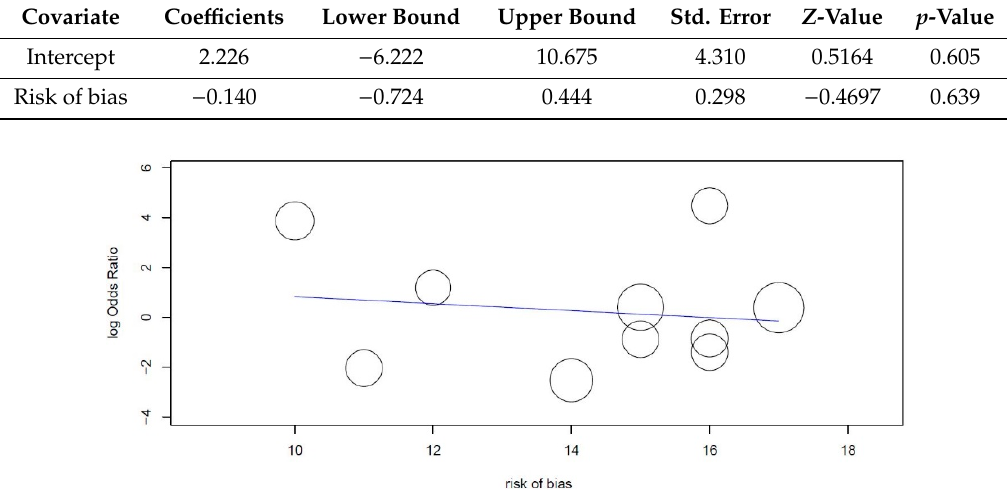
Table 8. Random e ff ects model: regression results for the risk of bias. Figure 8. Forest plot of the random effects model of the meta-analysis of the sub-group Propionibacterium; the arrows indicate the sources of heterogeneity that are identified by the funnel plot and are also evident on the forest plot. Sub-group culture (OR = 1.89, 95% CI: [0.31, 11.38]), sub- group PCR (OR = 0.45, 95% CI: [0.07, 3.02]).